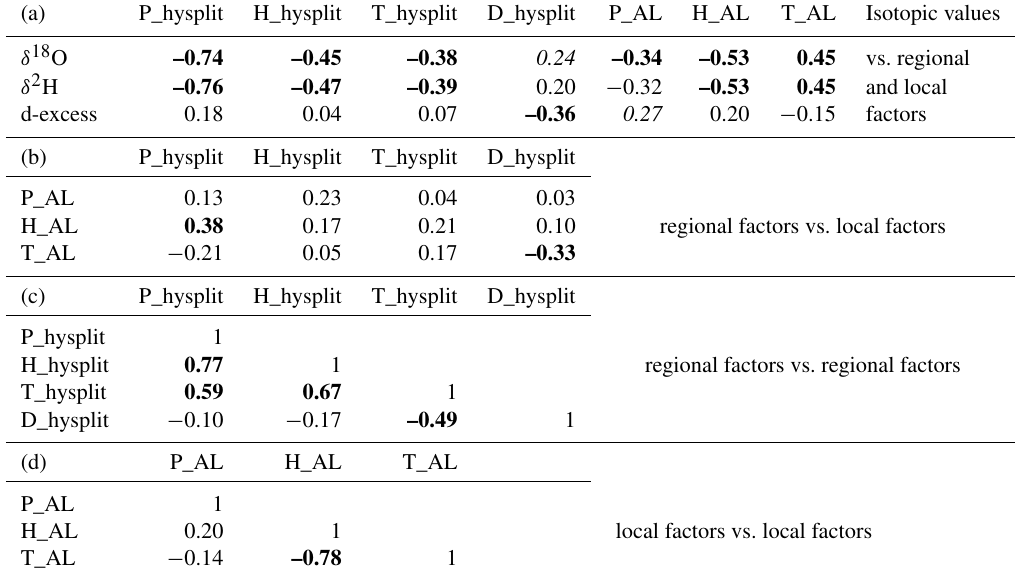
Table 2. Pairwise correlation coefficients between regional factors (P_hysplit, T_hysplit, H_hysplit, D_hysplit) and local factors (P_AL, T_AL, H_AL) and stable isotopic values ( δ 18 O, δ 2 H, and d-excess). Bold and italic numbers denote significance at the 0.01 and 0.05 level (2-tailed), respectively. The meteorological data are aggregated to weekly values corresponding to the precipitation sampling at An